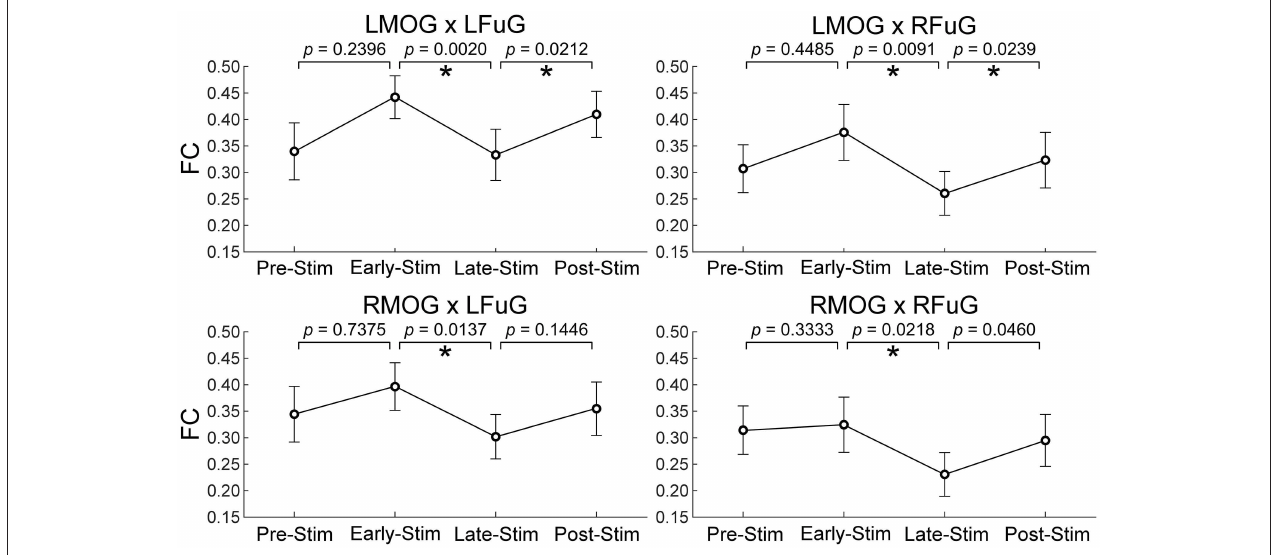
FIGURE 5 | Mean and standard error of mean (SEM) of FCs between higher and lower visual ROIs within four experimental sub-periods (the pre-stimulation period, PRE-STIM, − 10 to 0s; the early period of stimulation, EARLY-STIM, 0 to 10s; the late period of stimulation, LATE-STIM, 10 to 20s; the post-stimulation period, POST-STIM, 20 to 30s.) Here “0s” denoted the onset time of one visual presentation block. The p -values of FC difference between adjacent sub-periods were presented, and significant difference ( p < 0.05 , FDR corrected) between FCs within adjacent sub-periods was marked using